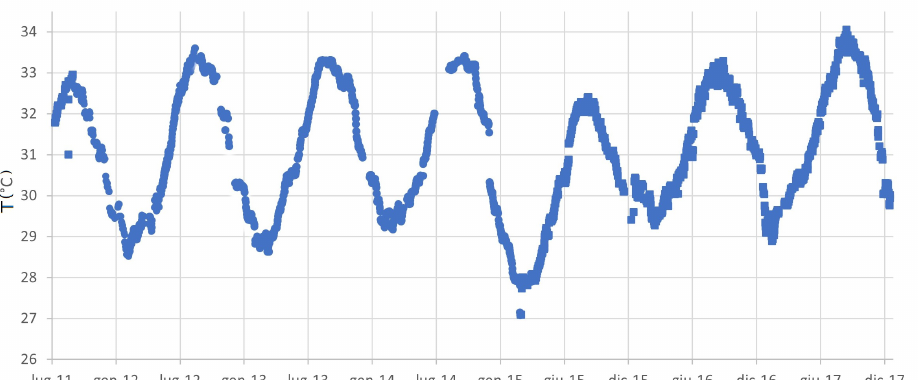
Figure 1. Scatter plot of the data series X ( t ) for the temperatures of the surface soil of the Campi Flegrei caldera at the Monte Olevano (NA) site, collected during the observation